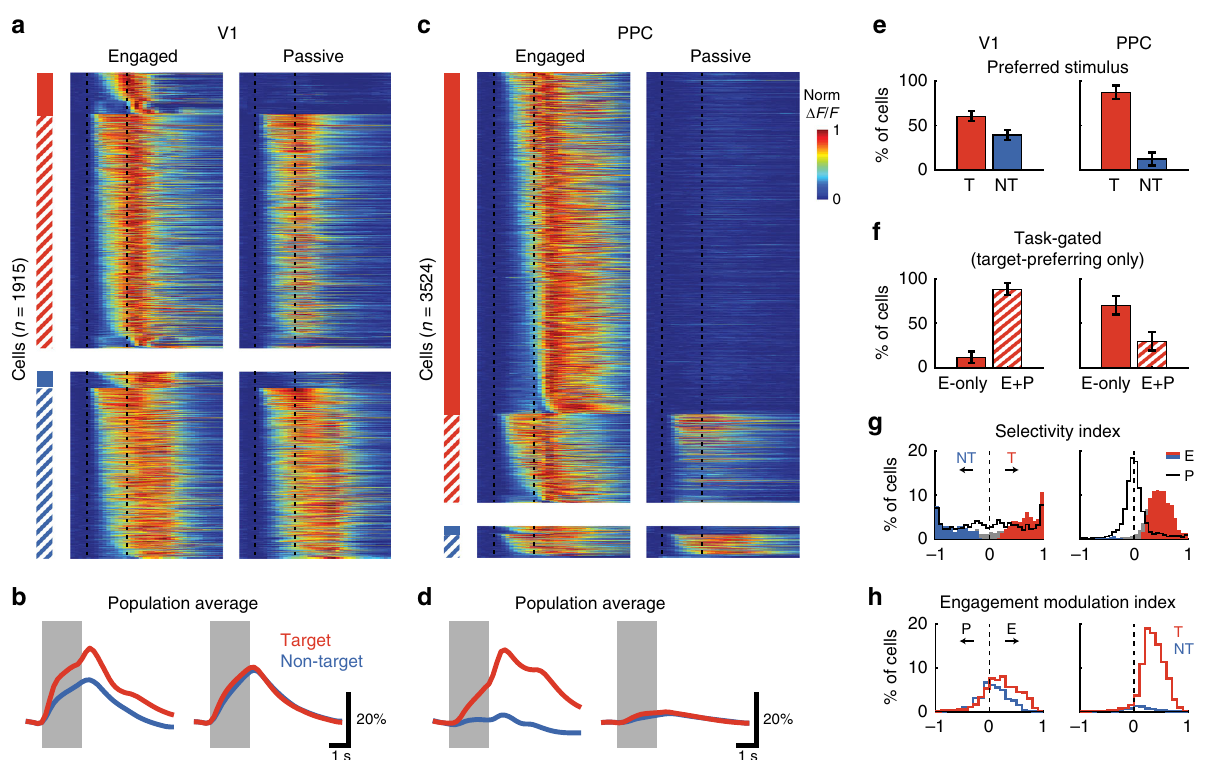
Fig 2 V1 neurons respond passively, whereas PPC responses are gated by task engagement. a Trial-averaged responses of all task-responsive V1 neurons ( n = 1915). Heatmap of all trial-averaged responses (preferred stimulus only) in both Engaged (left) and Passive (right) conditions, normalized by peak response. Neurons are separated into target-preferring (red) and non-target preferring (blue), and then into passive-responding (solid) and task-gated (hatched). Vertical dashed lines demarcate duration of stimulus. b Bottom, average response across V1 neurons to the target (red) and non-target (blue) in Engaged (left) and Passive (right) conditions. Line thickness indicates mean ± SEM. c , d Same as ( a , b ), but for PPC neurons ( n = 3524). e Percentage of neurons in V1 (left) and PPC (right) that prefer target (T) or non-target (NT) stimulus. Error bars represent bootstrapped SEM across sessions. f Percentage of target-preferring neurons in V1 (left) and PPC (right) that are task-gated, i.e. that respond only during engagement (E-only), or that respond during both engaged and passive conditions (E + P). g Histogram of stimulus selectivity index for V1 (left) and PPC (right) during Engaged ( fi lled bars) and Passive conditions (gray line). Positive selectivity indicates preference for Target. Colored bars indicate neurons with signi fi cant individual selectivity during Engaged trials. h Histogram of engagement modulation index for V1 (left) and PPC (right) for target- (red) and nontarget-preferring (blue)